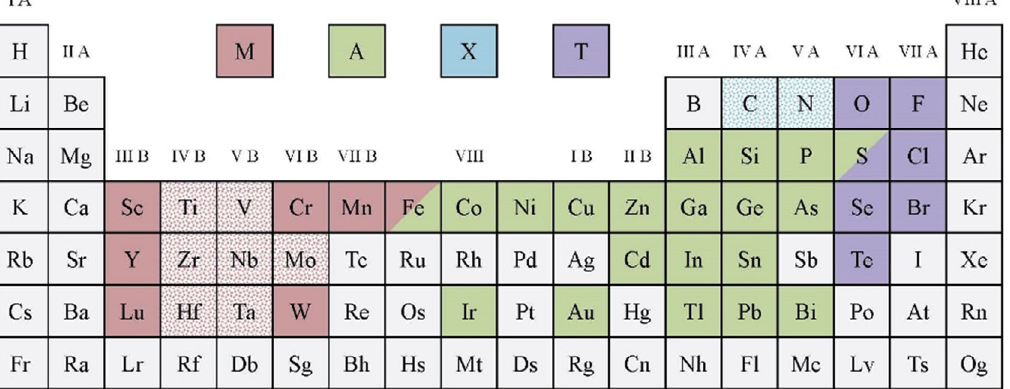
Fig. 1 Constitutive elements of MAX phases and MXenes in the periodic table. The pink, green, and blue colors indicate the M, A, and X elements in synthesized MAX phases, respectively. The pink and green colors with shading background indicate the M and X elements in prepared MXenes, respectively. The purple color indicates the common functional termination of prepared